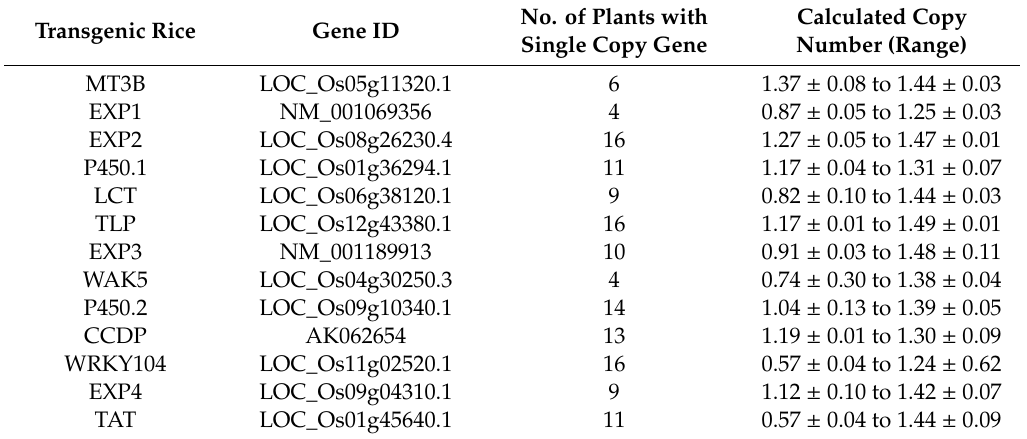
Table 3. Number of plants in each overexpression construct with single gene determined by Taqman qPCR